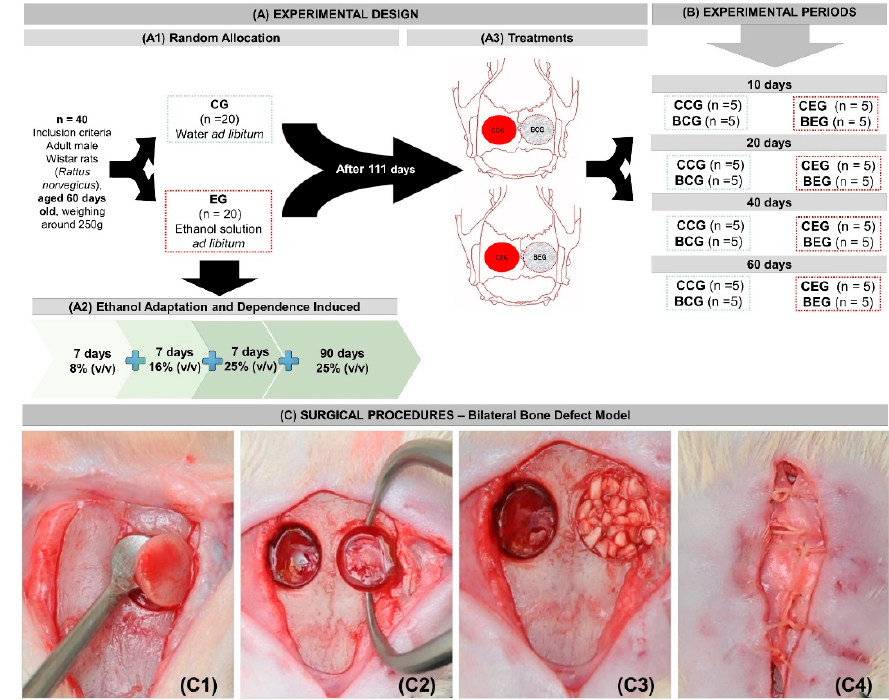
Figure 1. ( A ) Experimental design. ( A1 ) Random Allocation—Forty adult male Wistar rats, ( Rattus norvegicus ), aged 60 days old, weighing around 250 g were divided into two broad groups: CG—Control group ( n = 20)—that received only water with liquid diet and EG—Experimental group ( n = 20)—that received ethanol solution 25% ( v / v ) with liquid diet after adaptation period. ( A2 ) Ethanol Adaptation and Dependence Induced—Animals were gradually drunk at progressive concentrations of ethanol solution (8–16–25% v / v ). After 21 days of alcohol adaptation, the animals remained at 25% ( v / v ) until the surgical procedure for 90 days. ( A3 ) Treatments—After surgical procedures—bilateral bone defect model in the parietals, four subgroups were preformatted according to treatment (blood clot vs. biomaterial) and clinical conditions (alcoholic vs. non-alcoholic): Animals that received only water with liquid diet: CCG (right parietal bone defect was filled with blood clot) and BCG (left parietal bone defect was filled with biomaterial); Animals that received ethanol solution 25% ( v / v ): CEG (left parietal bone defect was filled with blood clot); BEG (right parietal bone defect was filled with biomaterial). B) Experimental Periods—at 10, 20, 40 and 60 days the skulls of 5 animals / group were collected, totalizing 5 defects / period of each subgroup CCG, BCG, CEG and BEG. (C) Surgical Procedures–Bilateral Bone Defect Model–( C1 ) 5-mm left parietal osteotomy; ( C2 ) Two bone defects in parietal bones; ( C3 ) One defect filled with biomaterial and the contralateral only with blood clot; ( C4 ) Periosteum suture with nylon